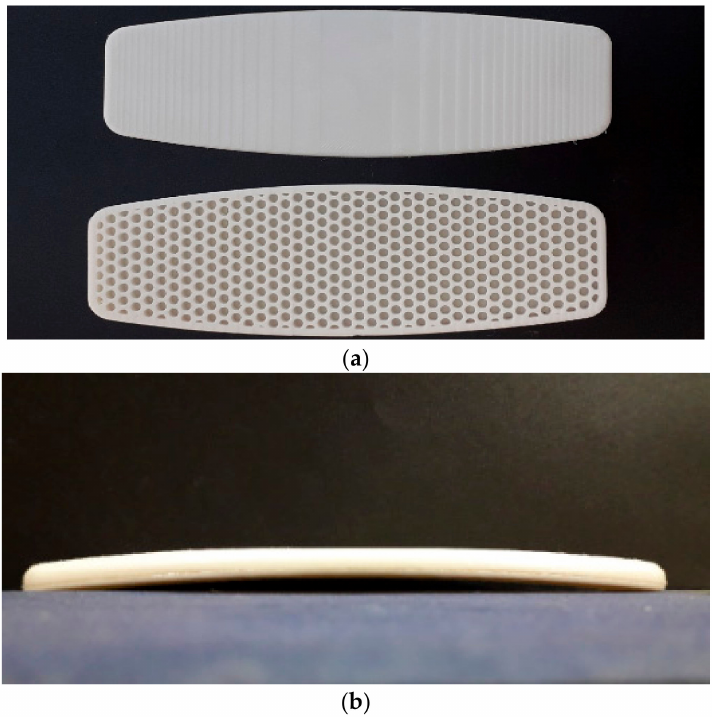
Figure 6. ( a ) Two separate 3D-printed parts of the board; ( b ) two parts glued together with strong